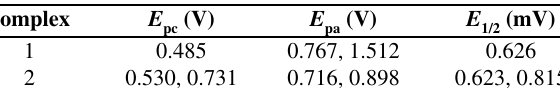
Table 3. Cyclic voltammetric data for complexes 1 and 2 (versus Ag/AgCl) complex